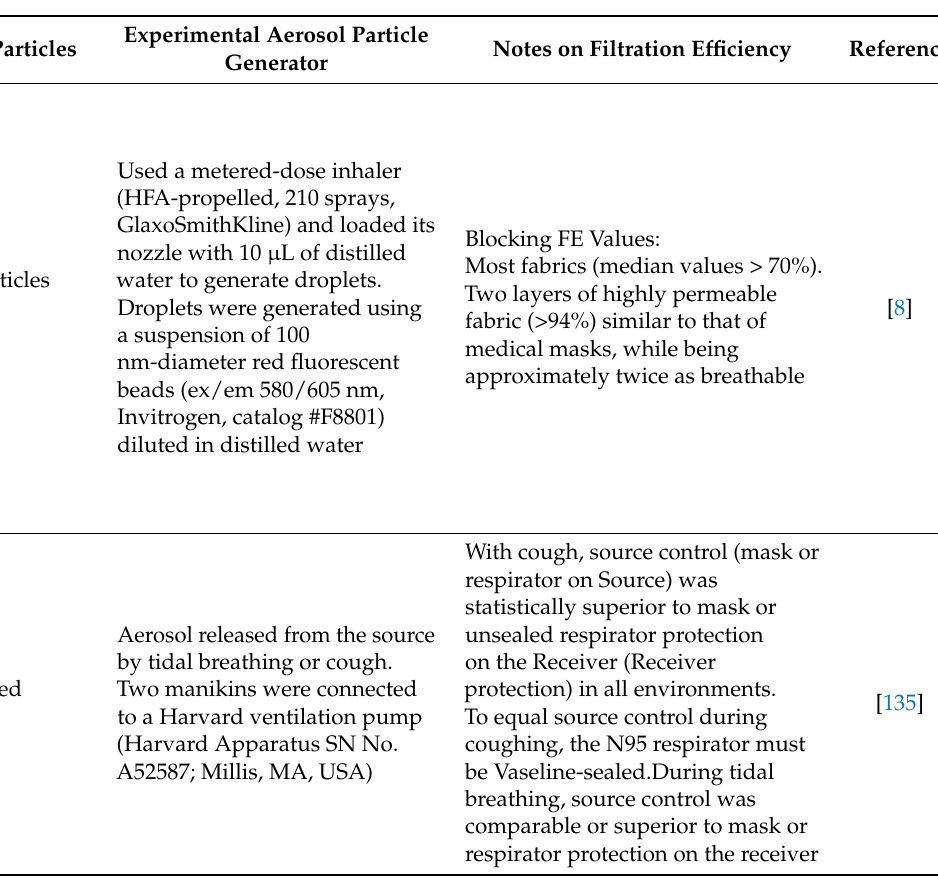
Table 9. Summary of face mask and respirator filtration experiments and testing practices using silicon dioxide, radioactive, and fluorescent aerosol